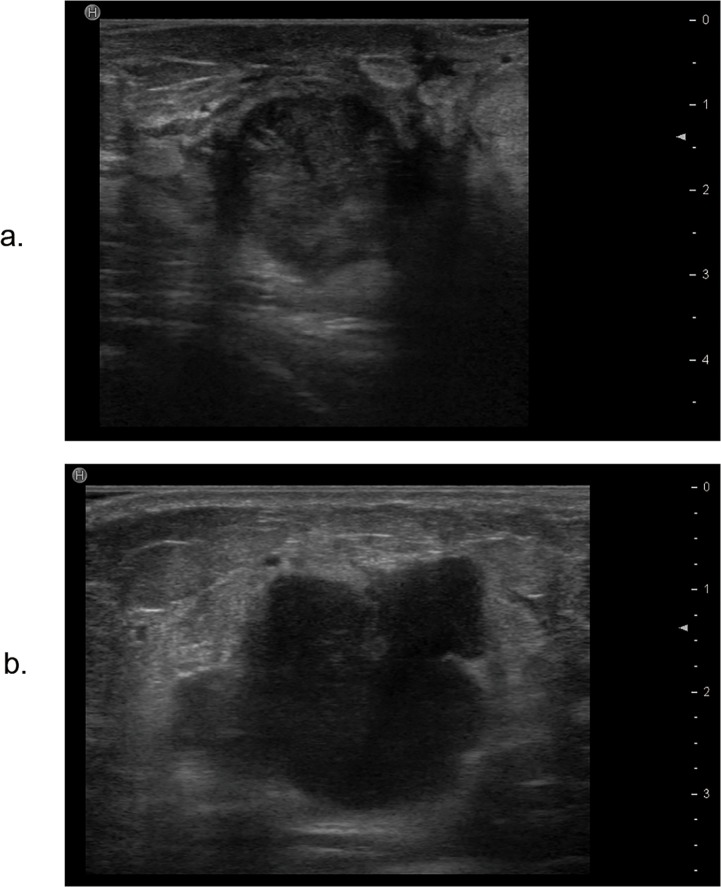
The relationship between lateral acoustic shadow feature on ultrasound and molecular subtypes of breast cancer.a. The ultrasound image of a tumor with lateral acoustic shadow is classified as the normal-like subtype according to the immunohistochemistry results. b. The ultrasound image of a tumor without lateral acoustic shadow is classified as the basal-like subtype according to the immunohistochemistry results.